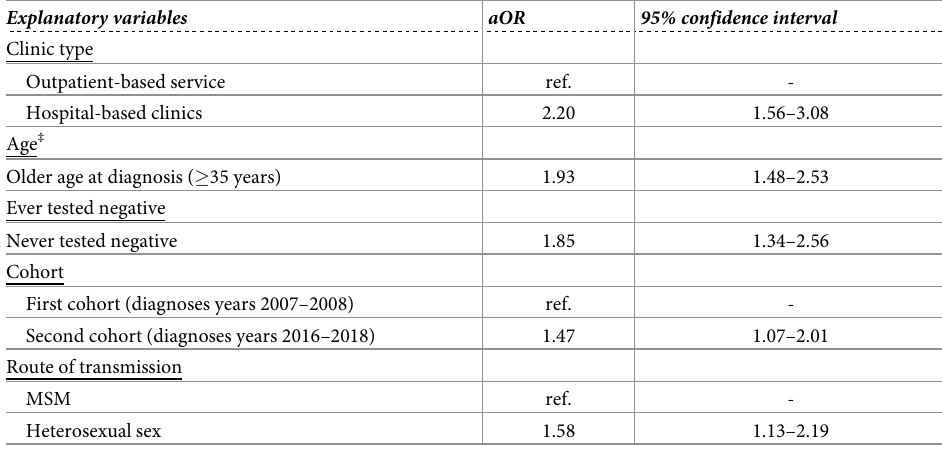
Table 4. Factors associated with late presentation of MSM and heterosexual patients in multivariable logistic regression model †